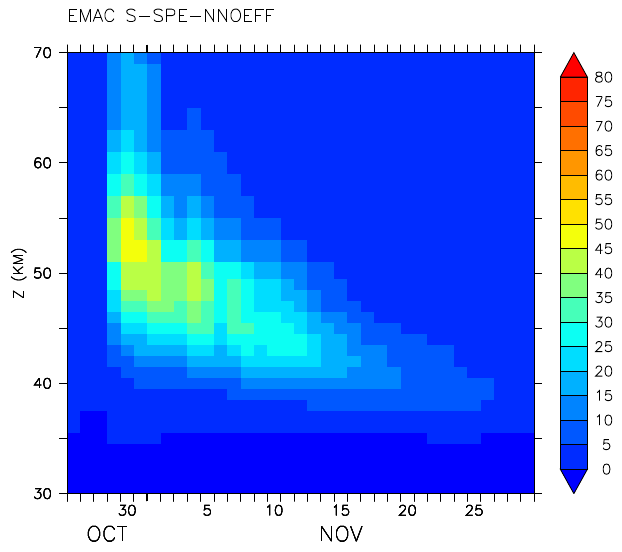
Fig. 10. NO 2 changes (ppbv) for 70–90 ◦ N relative to 26 October 2003 for simulation S-SPE-NNOEFF.